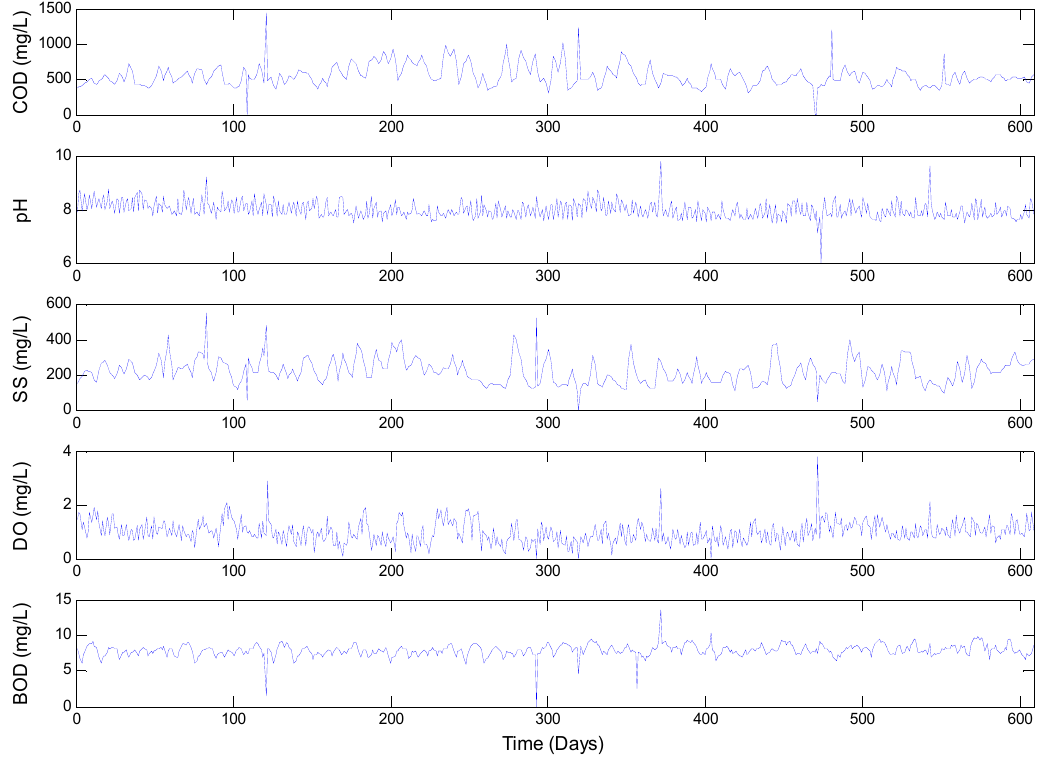
Figure 3. The original measured data used for effluent BOD modeling.